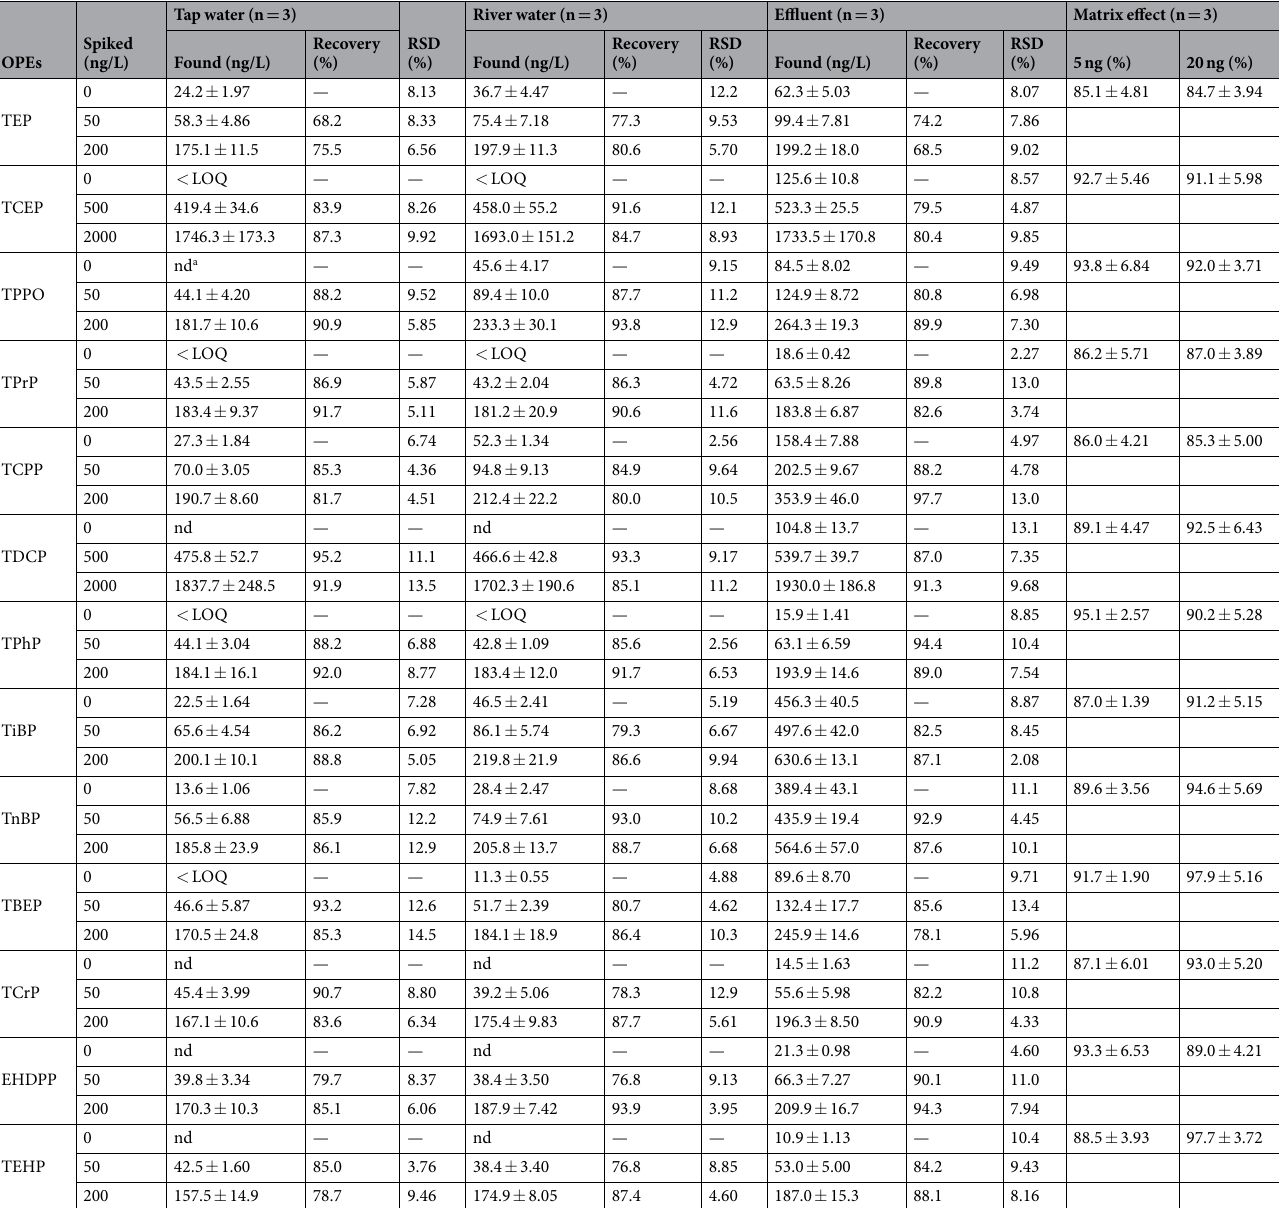
Table 2. The concentrations and recoveries of 13 OPEs in three different aqueous samples. a nd = not detected.